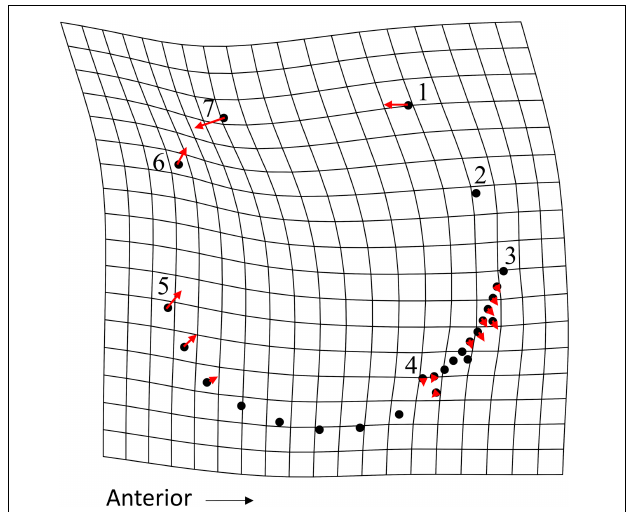
FIGURE 8 | TPS grid, with vectors showing magnitude and direction of LM and SLM deformation, illustrating the shape variation explained along the discriminate function analysis (DFA) axis (refer to Supplementary Figure 7 ) from maximum (live) to minimum (dead) scores for specimens from transects 6 and 7. Each point represents an LM (numbered 1–7, as presented in Figure 2 ) or an SLM (not